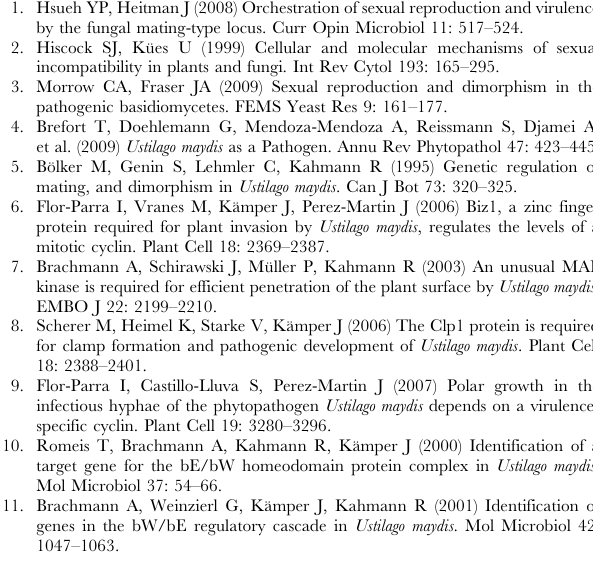
Figure S1 Kinetics of bW- and bE-expression driven by the arabinose inducible crg1 -promoter (strains AB31, AB32) and the nitrate inducible nar1 -promoter (strains AB33, AB34) in U. maydis . Found at: doi:10.1371/journal.ppat.1001035.s001 (3.75 MB TIF) Figure S2 Rbf1 is not required for pheromone-induced b - expression. Table S1 Alteration of gene expression in response to induced expression of bE1/bW2. Table S2 Overview of genes previously published as b -regulated. Table S3 Enrichment analysis for GO-categories of b -regulated genes. Table S4 Overview of gene expression after deletion/induction of rbf1 . Table S5 U. maydis strains used in this study.